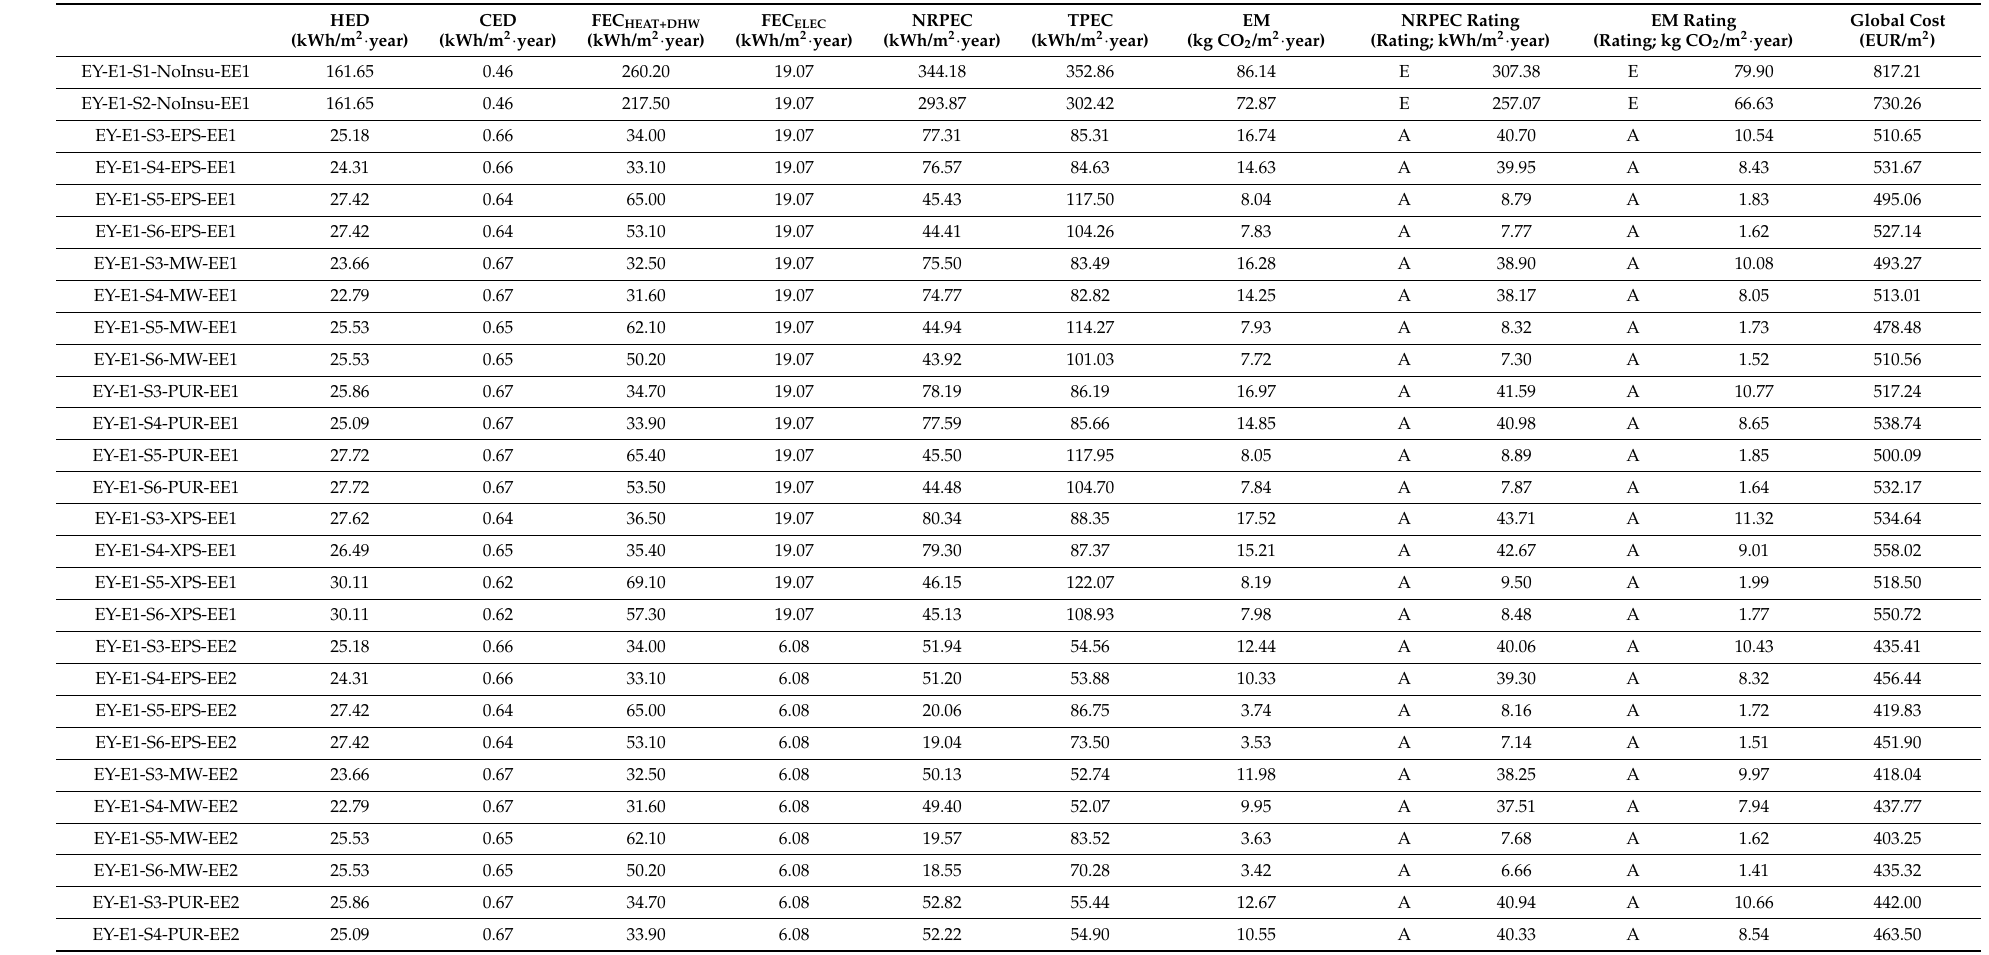
Table 9. Energy, environmental and economic impacts for each case study in Torrecilla en Cameros (CCZ